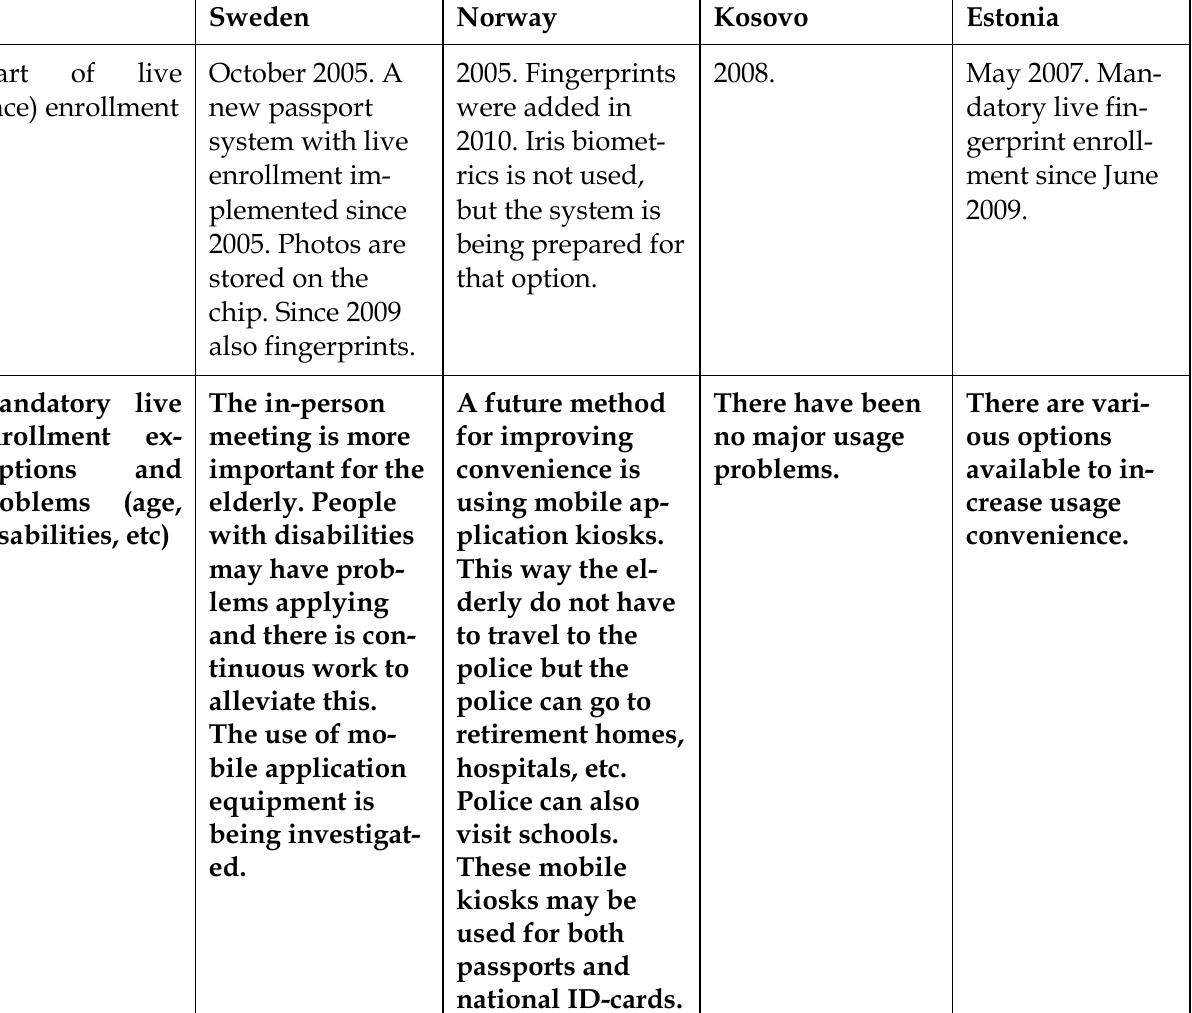
Table 1: The general passport background in Sweden, Norway, Kosovo, and Estonia Sweden Norway Kosovo